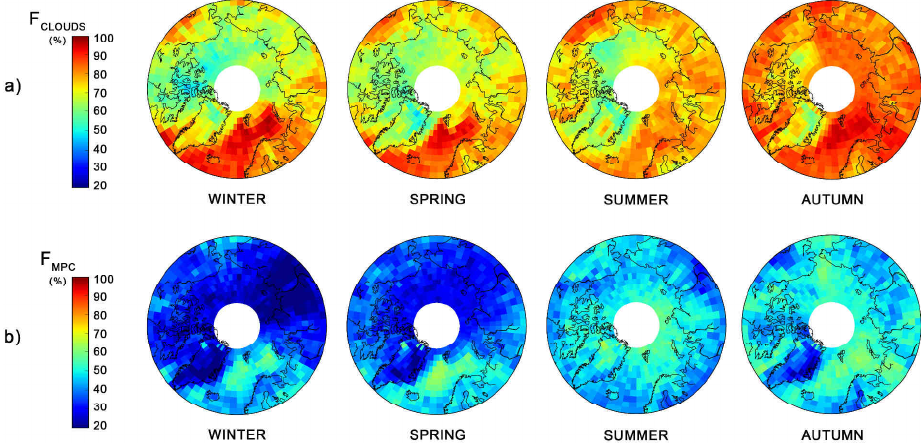
Figure 6. Stereographic projections of the seasonal occurrence of: (a) all clouds (referring to time) and (b) MPCs (referring to clouds). Occurrences are computed taking into account the 500 to 12000m altitude range.